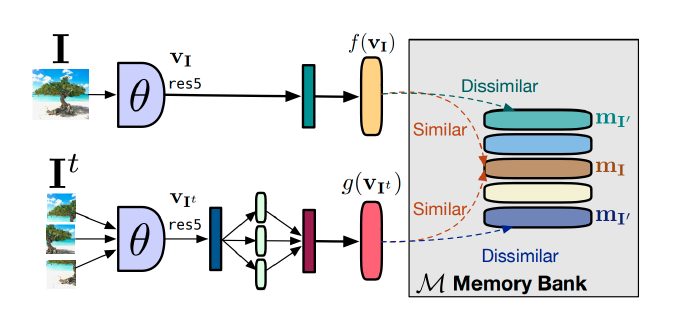
Figure 13. Usage of memory bank in PIRL: memory bank contains the moving average representa- tions of all negative images to be used in contrastive learning